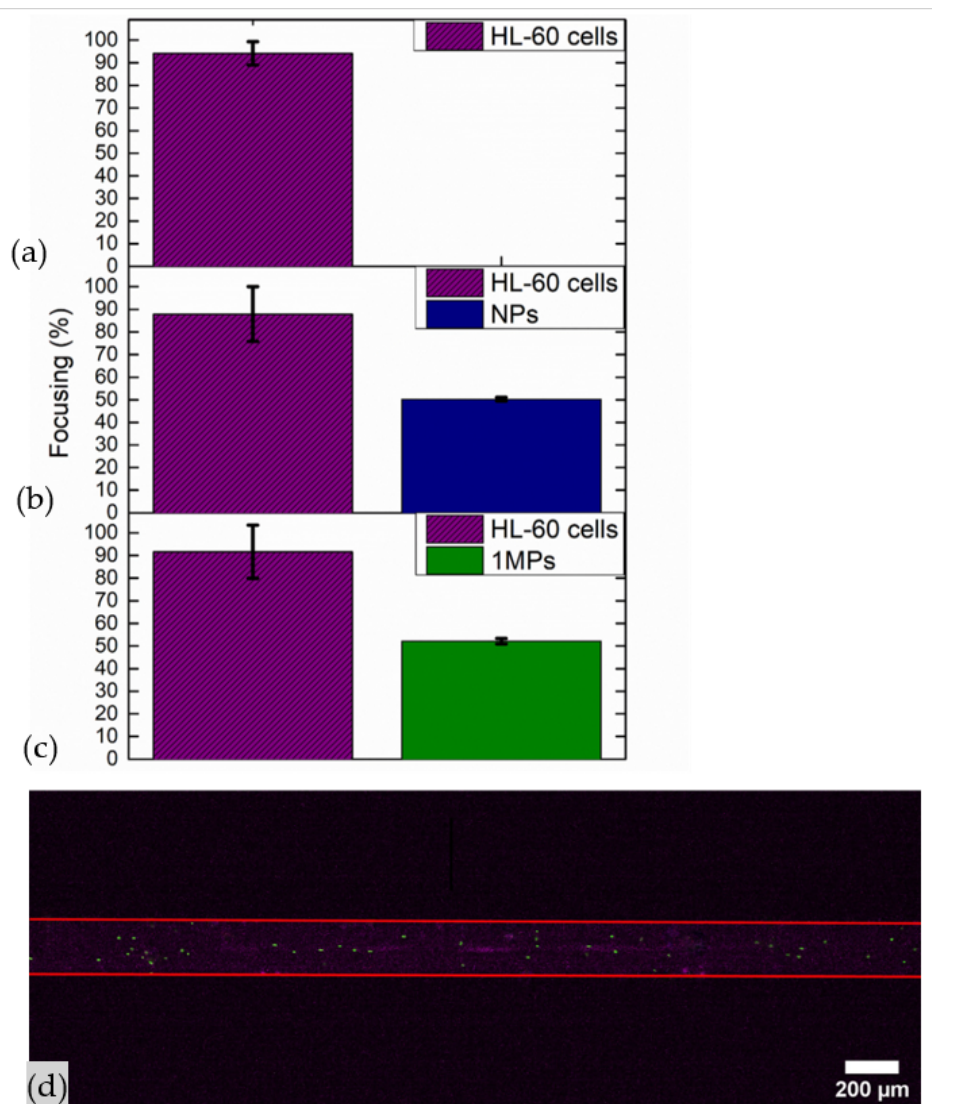
Figure 13. Focusing performance of the BAW device throughout a UV–Vis characterization: ( a ) HL-60 cells concentrated at 2.5 × 10 6 cells/mL, ( b ) HL-60 cells concentrated at 2.5 × 10 6 cells/mL mixed with 1MPs concentrated at 2.5 × 10 5 particles/mL and ( c ) HL-60 cells concentrated at 2.5 × 10 6 cells/mL mixed with NPs concentrated at 1.8 × 10 5 particles/mL. Mixed populations were injected at 3 µL/min when 50.59 Vpp was applied to the transducer, while the device was actuated at its resonance frequency of 4.623 MHz. ( d ) Frame of time lapse acquired during the acoustophoretic test, when the mixed population of HL-60 cells concentrated at 2.5 × 10 6 cells/mL and 1MPs 2.5 × 10 5 particles/mL was injected at 3 µL/min, 50.59 Vpp was applied to the transducer and the device was actuated at its resonance frequency of 4.623 MHz. Image acquired with 4 × objective lens with an exposure time of 20 ms for cells and 9.8 ms for